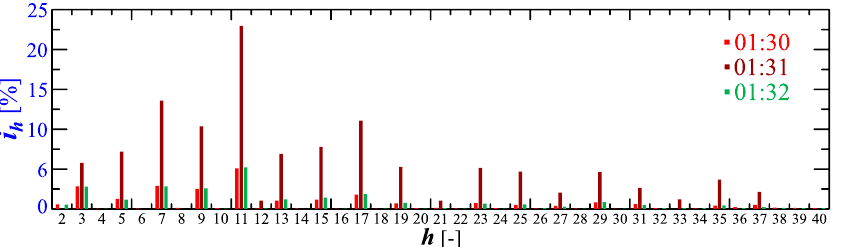
Figure 22. The amplitude spectrum of the current i h = f ( h ) recorded at 01:30, 01:31, and 01:32 for Case